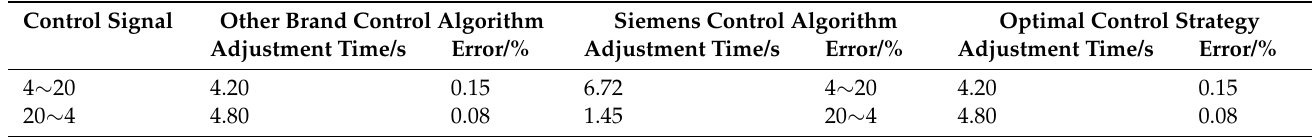
Table 5. Comparison of full-stroke intake/exhaust control